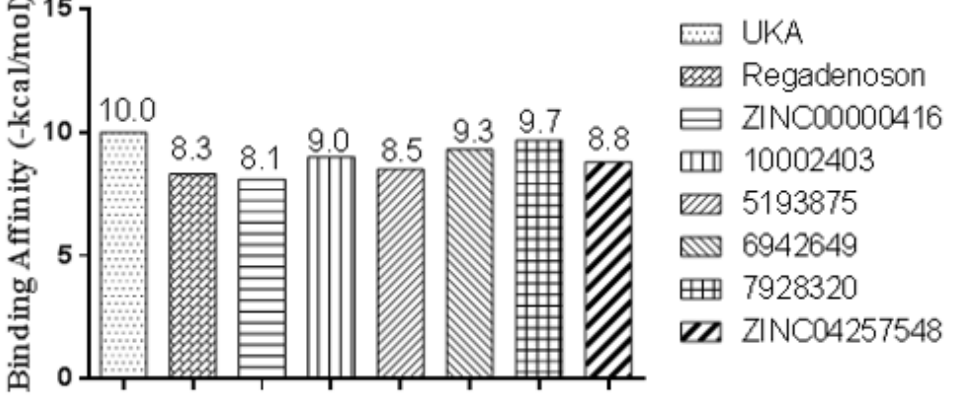
Figure 9. Theoretical binding a ffi nity for UK-432097, Regadenoson, ZINC00000416, Diverset CL 10002403, Diverset EXP 5193875, Diverset EXP 6942649, Diverset EXP 7928320, and ZINC04257548